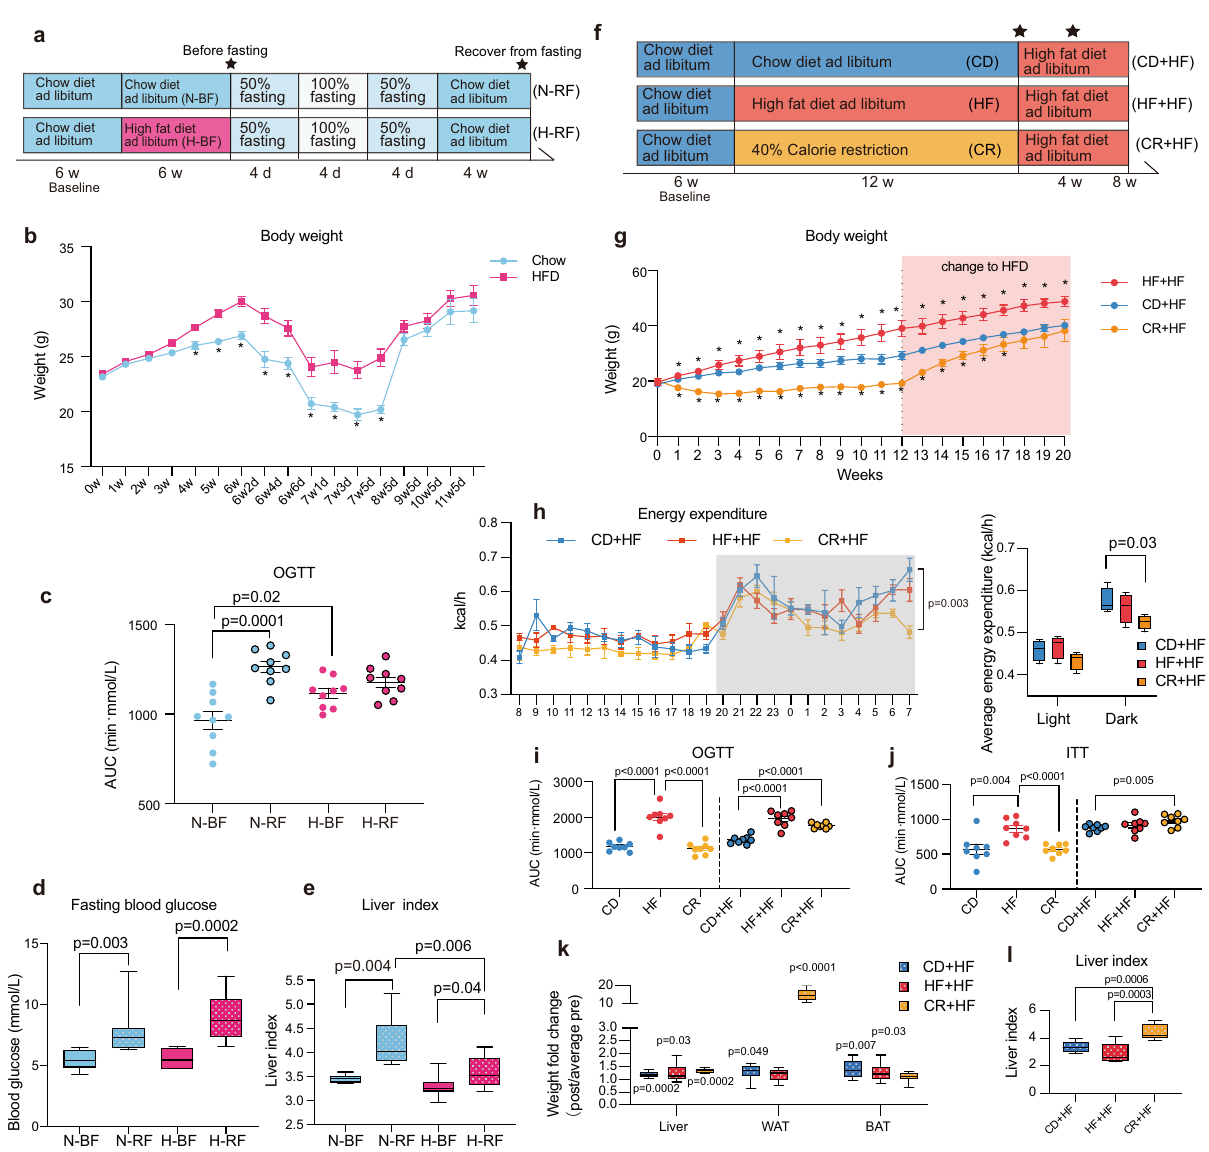
Fig. 1 The reinstatement of chow diet or HFD after fasting and CR resulted in rapid weight gain and obesogenic metabolic phenotypes. a The experimental work fl ow of the fasting experiment. The stars indicated the time of the samples collection. b Body weight in the fasting experiment. (* p < 0.05) c The AUC of OGTT. d Fasting blood glucose level. e Liver index level. f Work fl ow of the diets changing experiment. The stars indicated the time of the samples collection. g Body weight during the diets changing experiment ( n = 8 per group in the 16-week experiment and n = 6 per group for the observation of weight regain in 20 weeks. Differences were compared with the CD + HF group, * p < 0.05). h Raw energy expenditures and raw average energy expenditures in the period of light and dark, n = 4 per group. The hypothesis tests result of analysis-of-covariance with timely body mass as a covariate was shown in the left panel. i AUC of the OGTT. j AUC of the ITT. k Liver, WAT, and BAT weights fold change after change to HFD, the differences were compared between the pre and post changing diets. l Liver index level. n = 9 per group in the fasting experiment, n = 8 per group in the diets changing experiment. Data are expressed as means ± SEM ( c , i , j ). p -values in fi gures were calculated by the two-tailed unpaired T-test in the GraphPad software. All box and whiskers plots showed the box (from the 25th to 75th percentiles), the median value (in the transverse line), and the whiskers (go down to the smallest value and up to the largest). Source data are provided as a Source data fi le. Oral glucose tolerance test (OGTT); insulin tolerance tests (ITT); area under the curve (AUC); high-fat diet (HFD); epididymal white adipose tissue (WAT); brown adipose tissue (BAT). Remodeling of gut microbiota under CR or HFD . We suspected (Supplementary Fig. 1g) from the CR + HF group. After the HFD was reinstated, the healthy liver condition caused by CR changed that CR facilitated natural selection for organisms with higher to fat accumulation rapidly. We also found adipocyte hyper- energy-harvesting capability along with the decreased abundance trophy in WAT of the CR + HF group (Supplementary Fig. 1g). of less ef fi cient organisms, thus leading to a bodyweight regain The rapid weight rebound along with increased blood glucose and upon diet reinstatement. We collected the cecal contents from the fat accumulation in liver and adipose tissue was observed in the mice in HF, CD, and CR groups and performed whole-genome post-CR recovery period, suggesting the obesogenic metabolic shotgun metagenomic sequencing using the Illumina platform phenotype. (Supplementary Fig. 2a). Principal coordinate analysis (PCoA) at